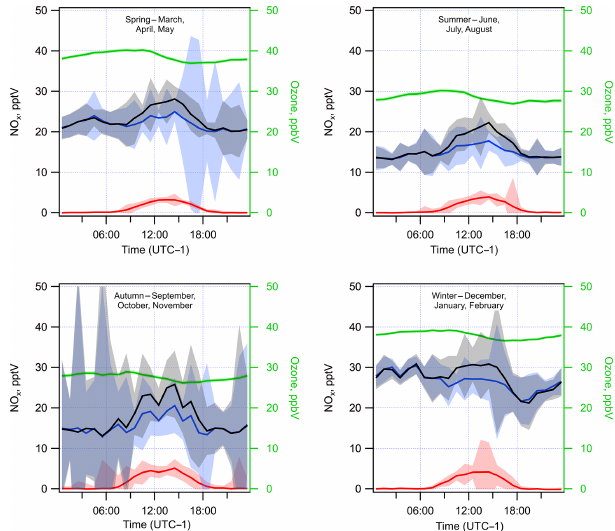
Figure 1. The observed seasonal diurnal cycles in NO, NO 2 , NO x , and O 3 at the CVO GAW station during 2014 and 2015. NO is shown in red, NO 2 in blue, NO x in black, and O 3 in green. Shaded areas indicate the standard error of data.